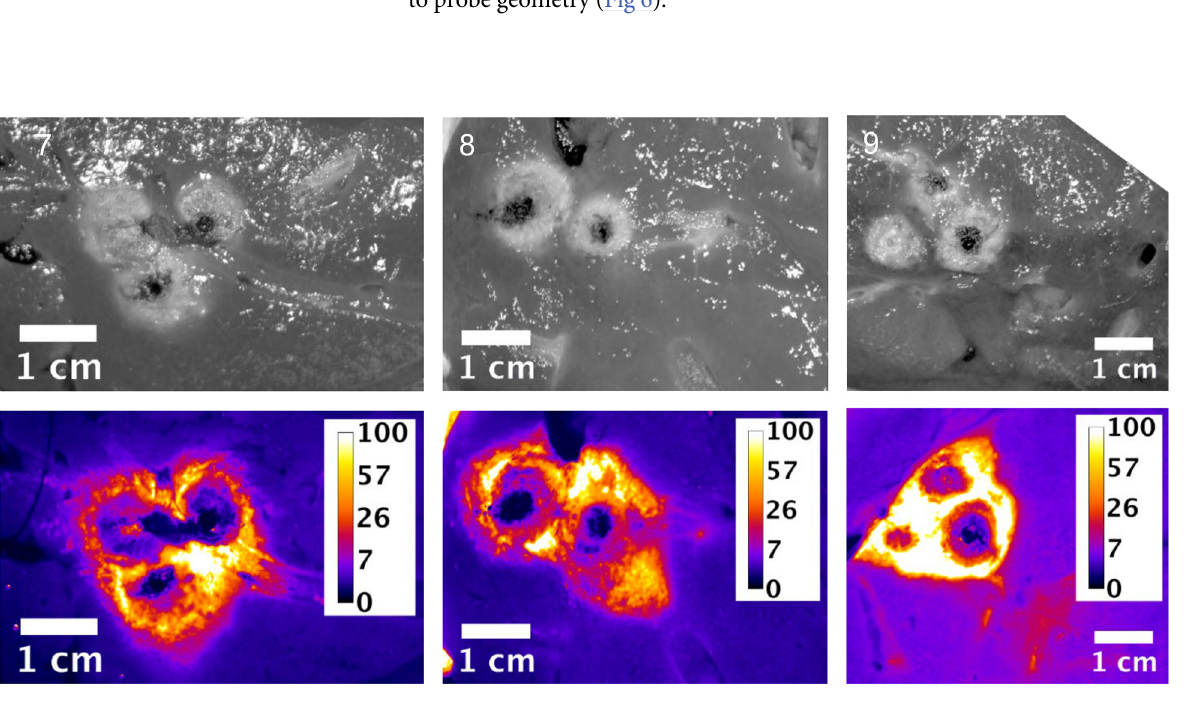
PLOS ONE | DOI:10.1371/journal.pone.0139752 October 2,